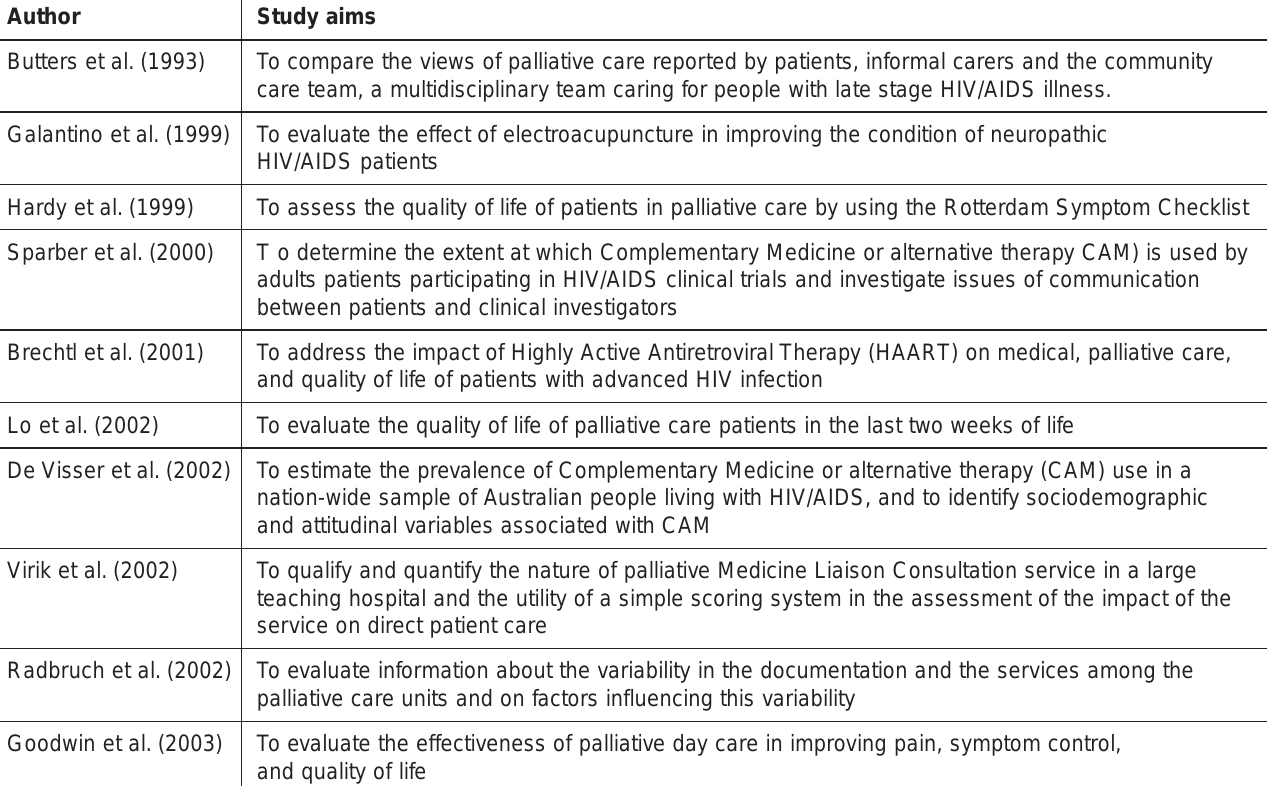
Table 5: Study Aims of Surveys.